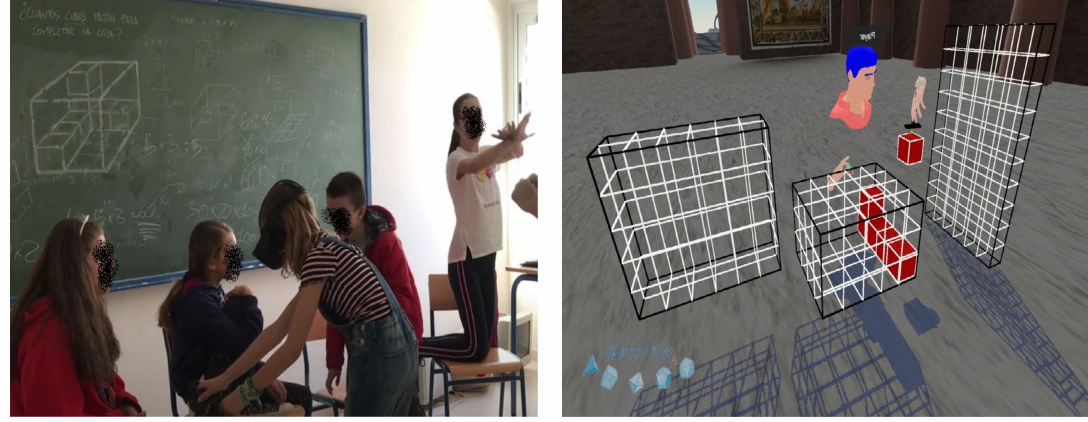
Figure 13. Student explaining the procedure through gestures and a scene of the proposed activity in Neotrie.